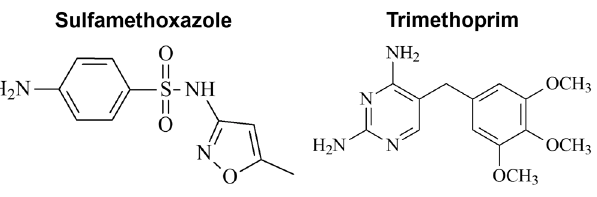
Figure 1. Molecular structures of Sulfamethoxazole (SMX) and Trimethoprim (TMP). As an alternative for minimizing the matrix effect, the use of SERS coupled with other